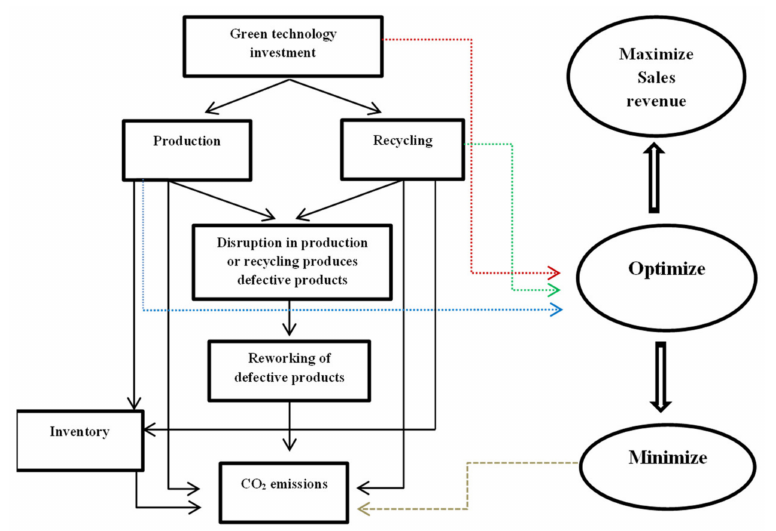
Figure 4. Integration of recycling, carbon emission, and imperfect system for the EPQ model